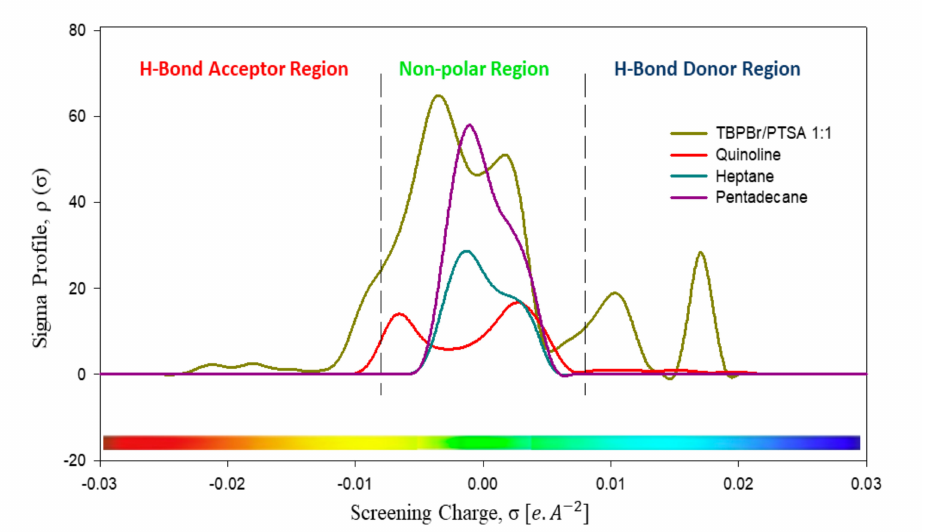
Figure 3. Sigma profiles of all species in the heptane system and in the pentadecane system. The region between − 0.008 eA − 2 < σ < + 0.008 eA − 2 indicates the London dispersion force in heptane. Peaks at σ hb > + 0.008eA − 2 indicate hydrogen bonding energy and the presence of hydrogen bond donor, while peaks at σ hb < + 0.008eA − 2 indicate the presence of a hydrogen bond acceptor